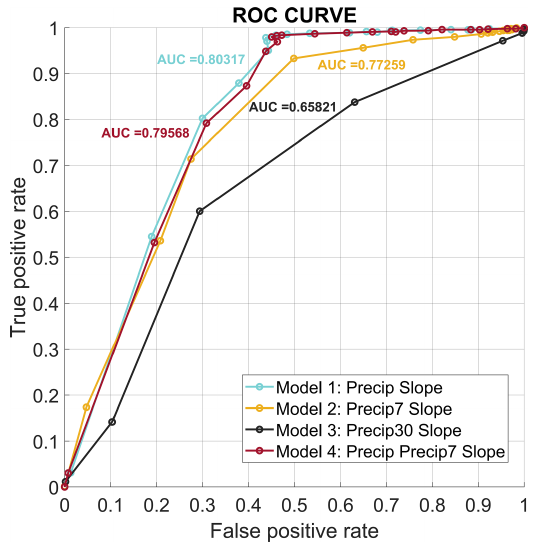
Figure 7. ROC curve for thresholds of 5% to 99% for logit models.